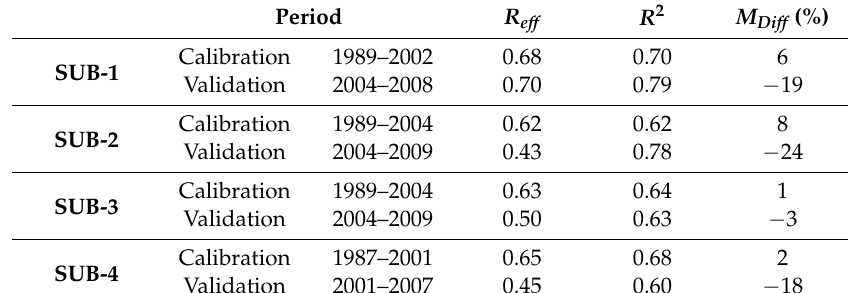
Table 3. The model performance statistics for the calibration and validation periods.